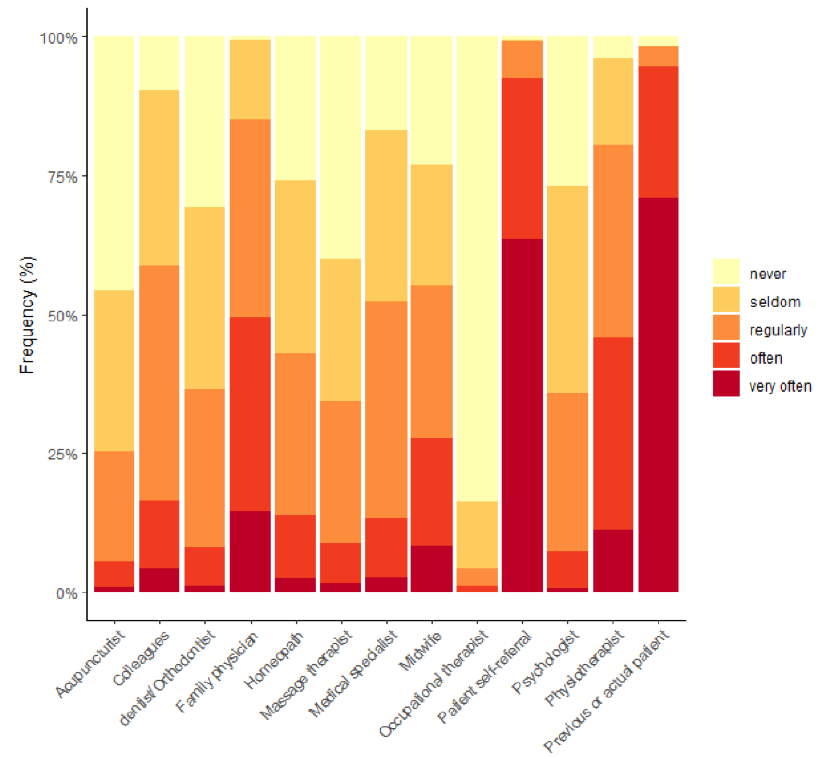
Figure 3. Frequency of referral of patients by other health professionals to osteopaths (%).